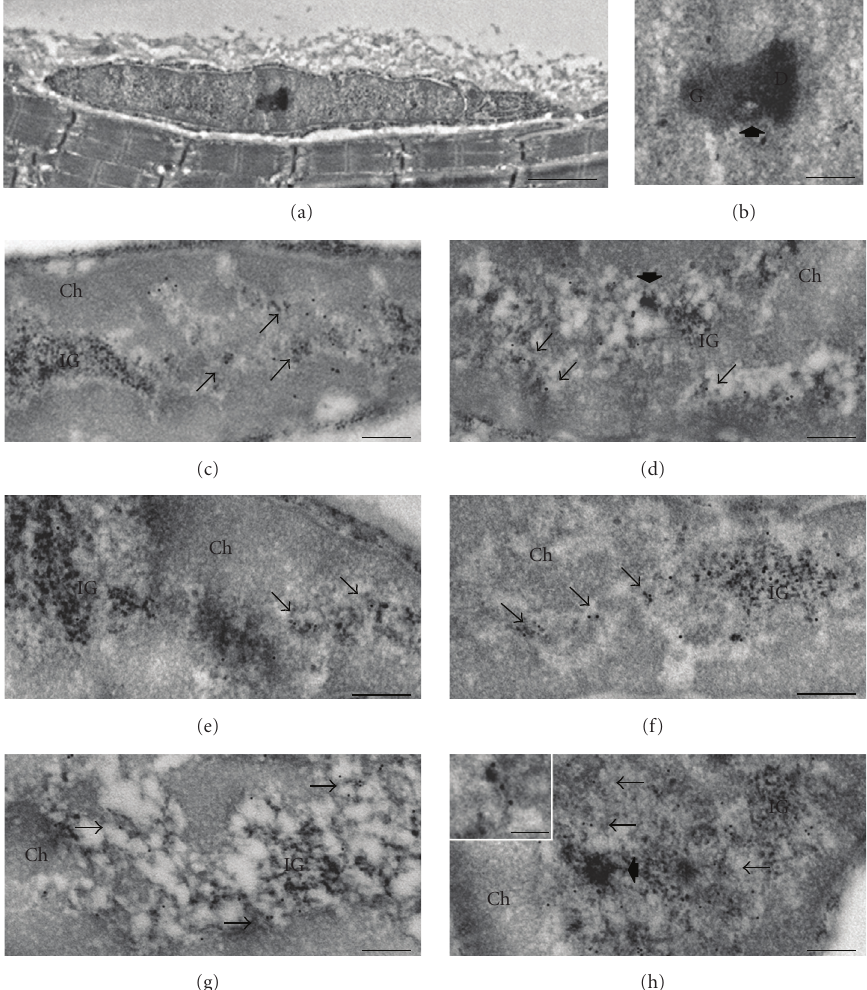
Figure 2: Transmission electron micrographs. (a) Satellite cell bordering a myofiber. (b) Detail showing the nucleolus mostly composed of granular component (G); whereas the dense fibrillar component (D) is less abundant, note the small fibrillar center (arrowhead). Satellite cell nuclei from adult (c, e and g) and old (d, f and h) rats. (c and d) Quadriceps muscles, anti-polymerase II (12nm), and anti-DNA/RNA hybrid (18nm) antibodies: both antibody probes specifically label perichromatin fibrils (arrows). Note the clustered perichromatin fibrils in (d) (arrowhead). The interchromatin granules (IG) are unlabeled. (e, f) Biceps muscles, anti-snRNP antibody: perichromatin fibrils (arrows) and interchromatin granules (IG) are labeled. (g, h) Quadriceps muscles, anti-CstF antibody: gold grains specifically label perichromatin fibrils (arrows) and RNP tails rising from perichromatin granules (inset). Note the cluster of perichromatin fibrils in (h) (arrowhead). Interchromatin granules (IGs) are unlabeled. Ch: condensed chromatin. Bars: (a) 1 μ m; (b–h) 250 nm; inset